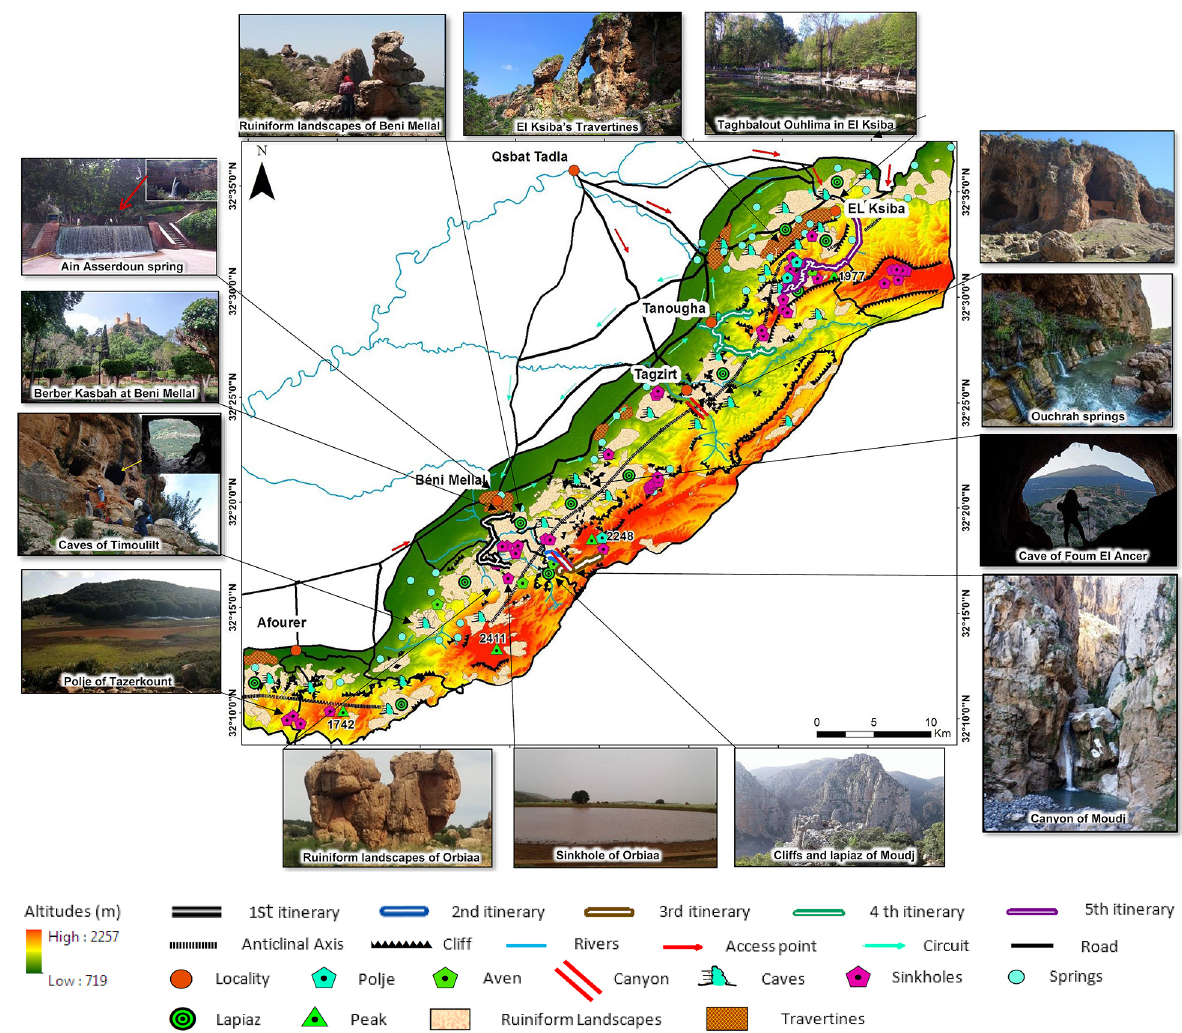
Fig. 12. Geotouristic map of the study